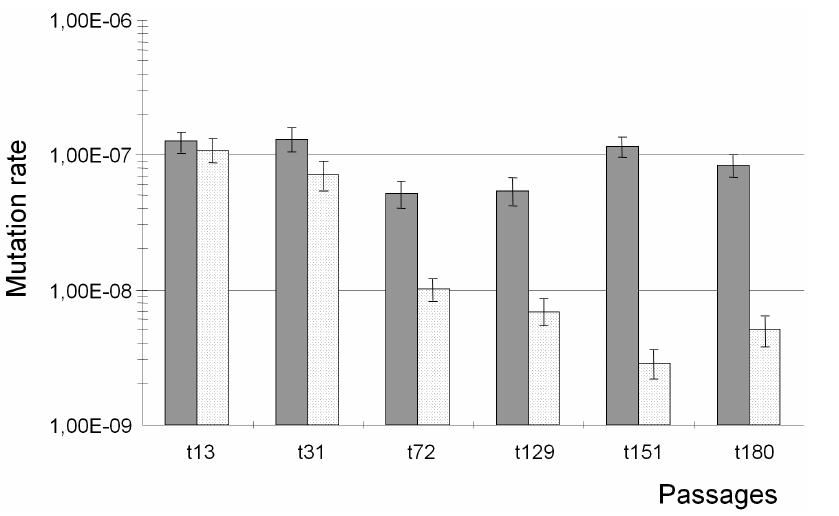
Figure 2. Mutation rates of colonies with high and low mutation frequencies obtained in the same passage, along time. In the y axis, mutation rates (Luria-Delbru¨ck method); in the x axis, numbers of the serial passages in which mutation rates were determined. Bars in grey correspond to colonies with high mutation frequencies; white dotted bars correspond to colonies with low mutation frequencies.